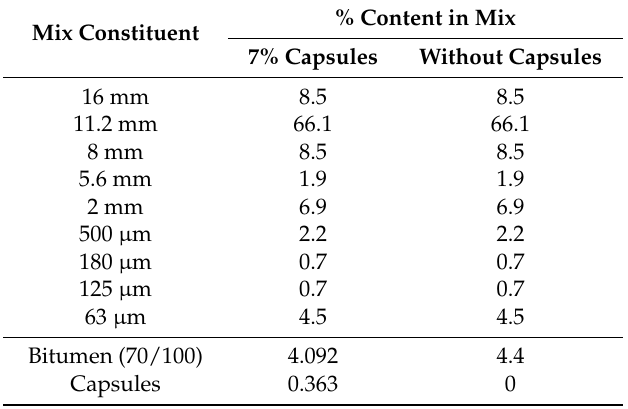
Table 1. Mix composition of Porous Asphalt Concrete.